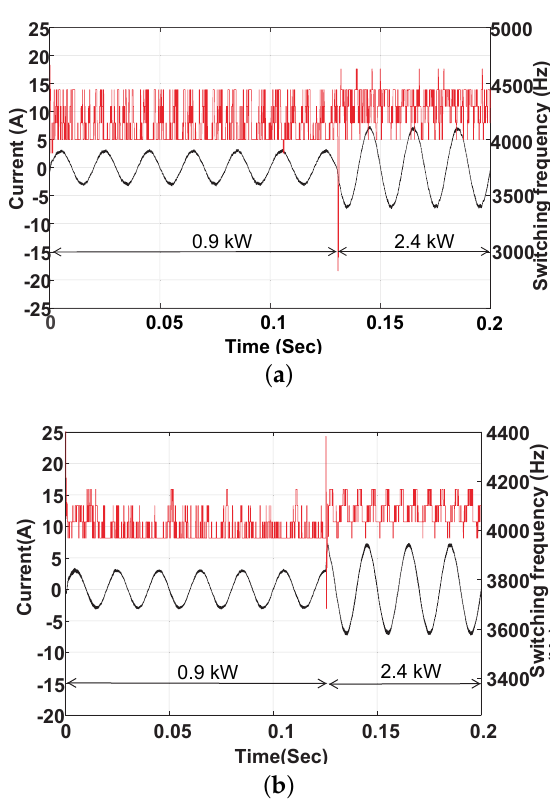
Figure 20. Sampling effect: a comparison between the switching frequency and currents response of the 40 kHz and 80 kHz samplings. ( a ) A step response from 2.2 kW to 5.2 kW when Ts = 25 µ s; and ( b ) a step response from 2.2 kW to 5.2 kW when Ts = 12.5 µ s. ( a ) Experimental results: the dynamic response for a VSC using a periodic control strategy having a 40 kHz sampling; ( b ) Simulated dynamic response for VSC using periodic control strategy having an 80 kHz sampling